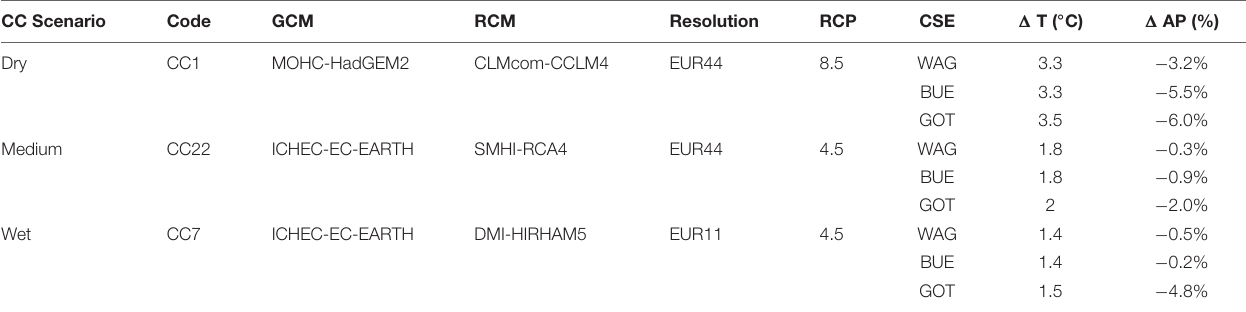
TABLE 3 | Selected climate change (CC) scenarios from Brunner et al. (2019) at the different case study enterprises (CSEs). CC